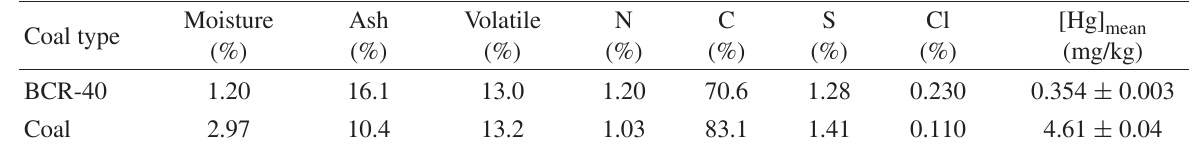
TABLE 1: Major components of BCR-40 and coal sample (dry air basis).